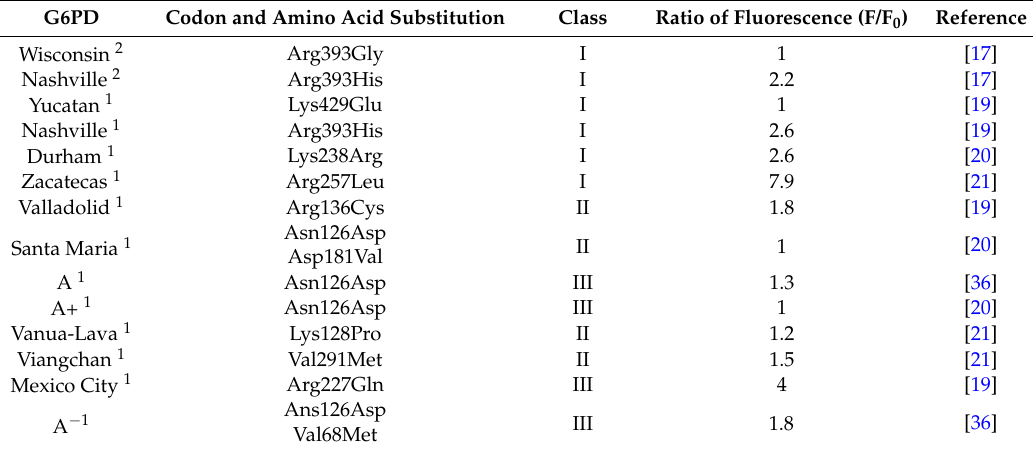
Table 5. Analysis of conformational changes by 8-Anilinonaphthalene-1-sulphonate (ANS) assay for the WT and G6PD